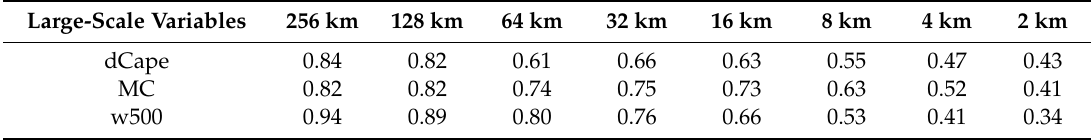
Figure 10. Lead-lag correlation between convective precipitation and mass flux at different pressure levels for ( a ) 256 km subdomain, ( b ) 128 km subdomain, ( c ) 64 km subdomain, ( d ) 32 km subdomain, ( e ) 16 km subdomain, ( f ) 8 km subdomain, ( g ) 4 km subdomain and ( h ) 2 km subdomain. Negative (positive) values on x-axis represent mass flux leading (lagging) convective precipitation by a given amount of time. The correlation is contoured at values of 0.1, 0.2, 0.4, 0.6, 0.8, 0.9, 0.925, and 0.95. Table 1. Maximum correlation coe ffi cients between convective precipitation and coarse-grained global climate model (GCM) equivalent